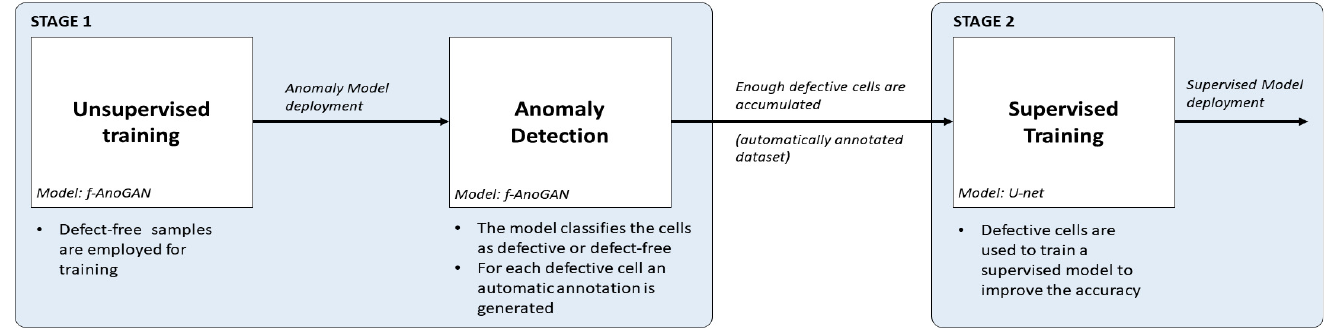
Figure 2. General schema of the proposed methodology. (1) In the unsupervised training, the network for anomaly detection is trained with defect-free samples. (2) In anomaly detection, the network from the previous step is applied to detect and locate defects, thus generating an automatically labeled dataset. (3) Finally, the generated dataset is employed to train a supervised model that improves the detection